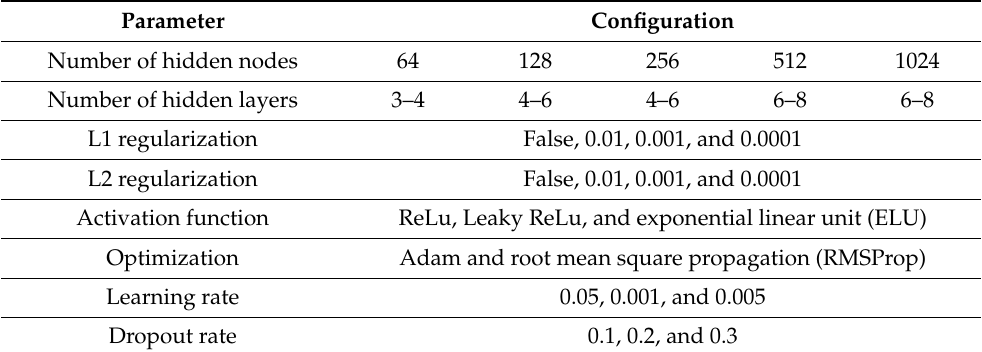
Table 1. Hyperparameter range used to select the optimal deep-learning model structure for estimat- ing ground-level PM 2.5